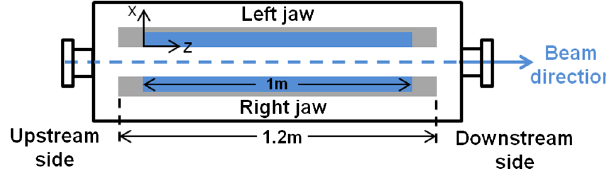
FIG. 5. Top schematic view of a horizontal TCT (not to scale). The blue bars represent the five W jaw inserts (total length ¼ 0 . 2 m × 5 ¼ 1 m), that are screwed to the copper housing (grey).